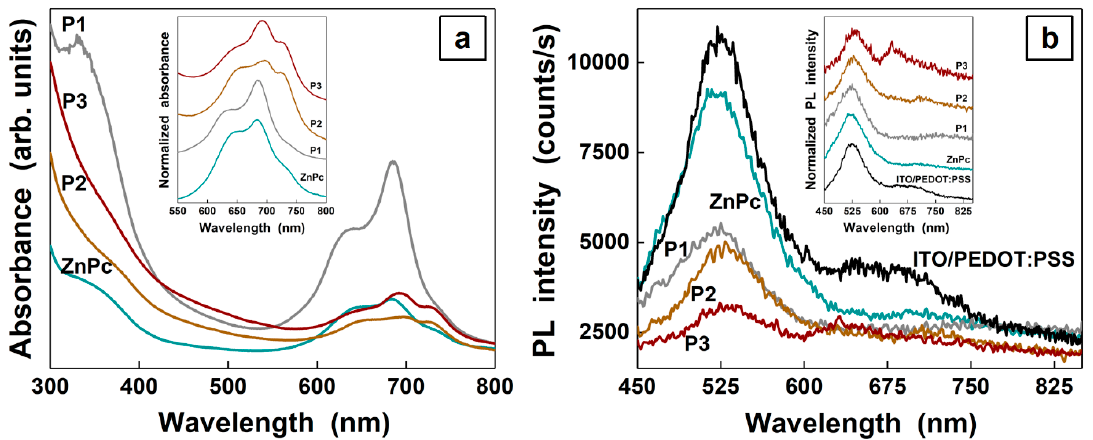
Figure 2. UV-Vis spectra ( a ) and PL spectra ( b ) of the MAPLE-deposited organic layers on glass ( a ) and ITO/PEDOT:PSS ( b ).